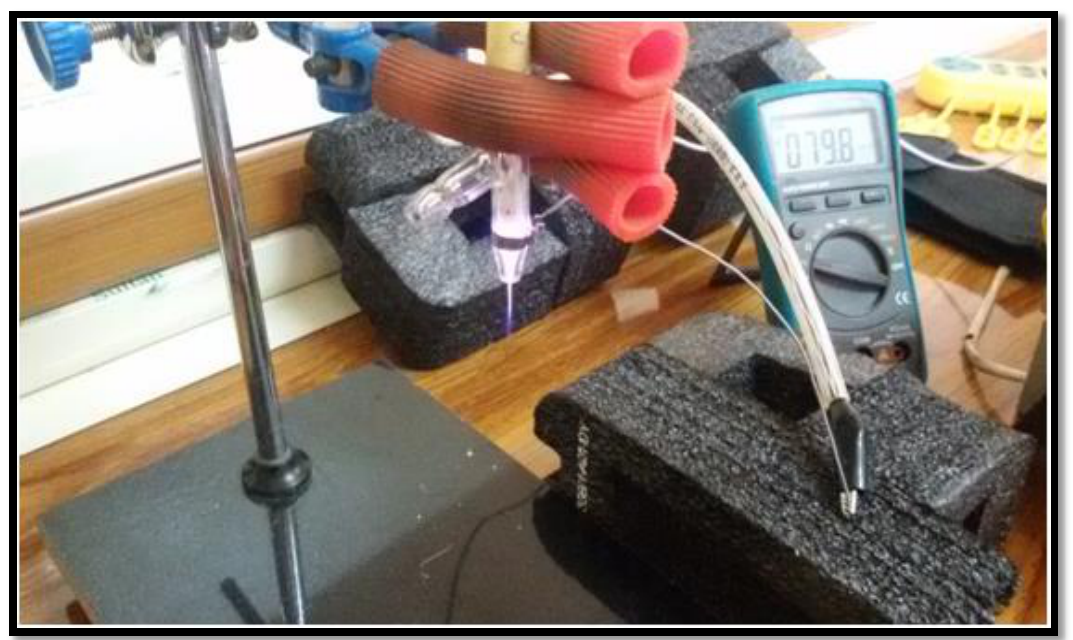
Fig. 1: Plasma torch experiment